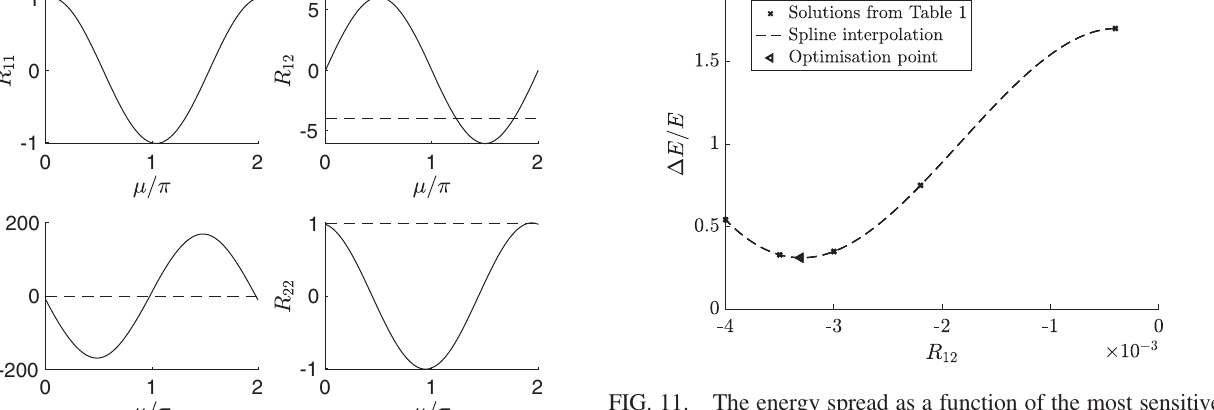
FIG. 11. The energy spread as a function of the most sensitive transfer matrix element R 12 . Data points from Table I are interpolated to determine the R 12 value yielding the minimum energy spread of 0.31 keV at the end of DLW 2 .